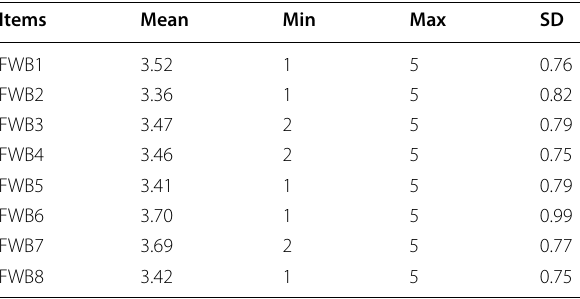
Table 3 Level of financial well-being (FWB) of the respondents